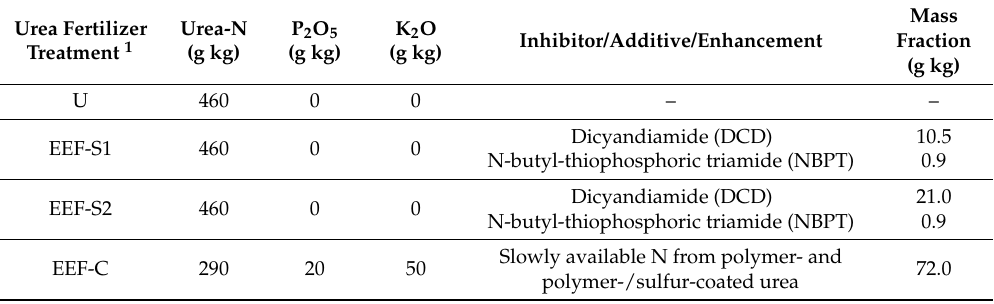
Table 1. Described grade and enhancement of the employed granular